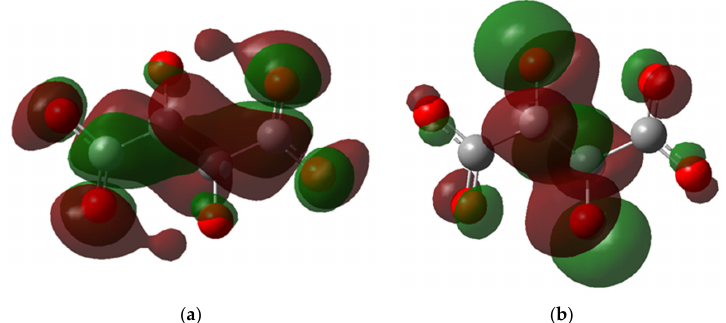
Figure 7. The molecular orbital maps, ( a ) LUMO and ( b ) HOMO, of the PESA-H-H-1n molecule.